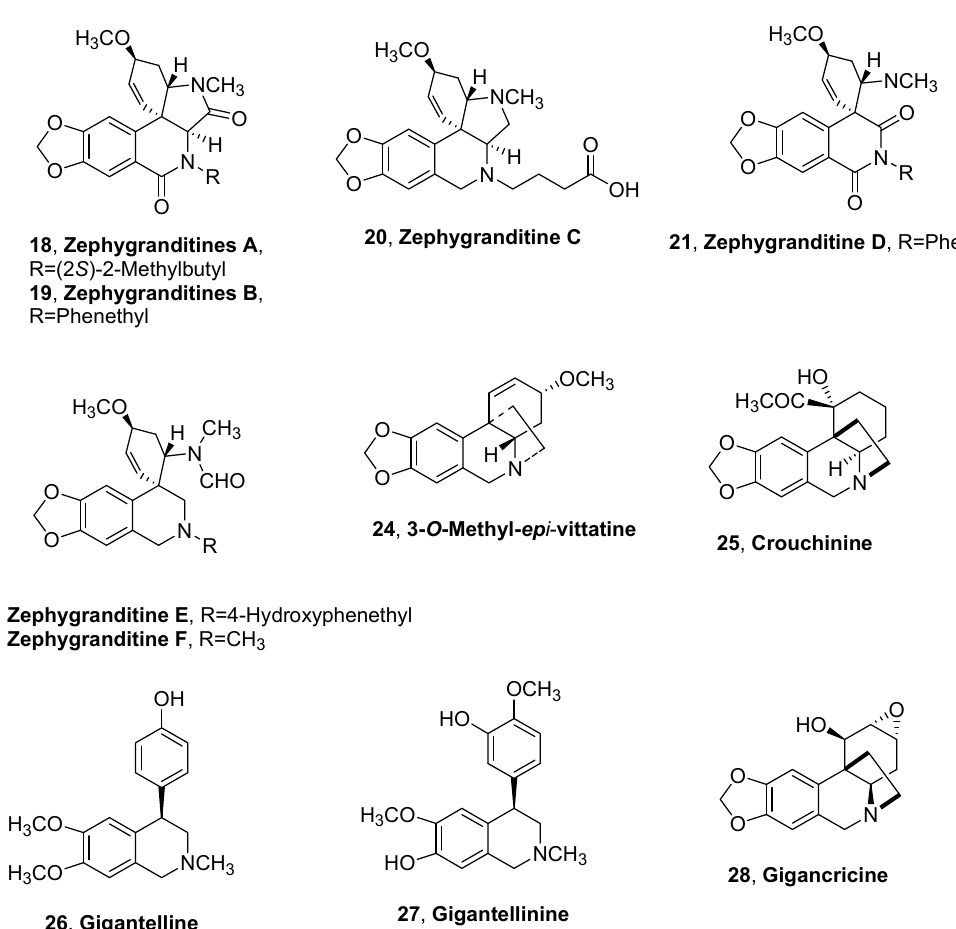
Figure 2. Alkaloids isolated from Zephyrantes grandiflora , Brunsvigia natalensis , and Crinum jagus